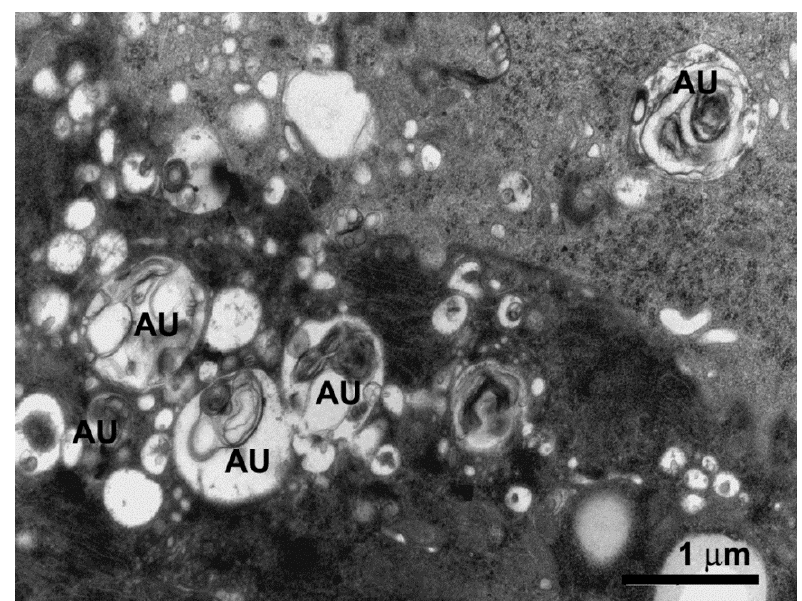
Figure 6. Transmission electron micrograph of the median region of the digestive cell in the midgut of Friesella schrottkyi worker showing well-developed nucleus (N) with decondensed chromatin and large nucleolus (Nu) and the perinuclear cytoplasm with rough endoplasmic reticulum (RER).